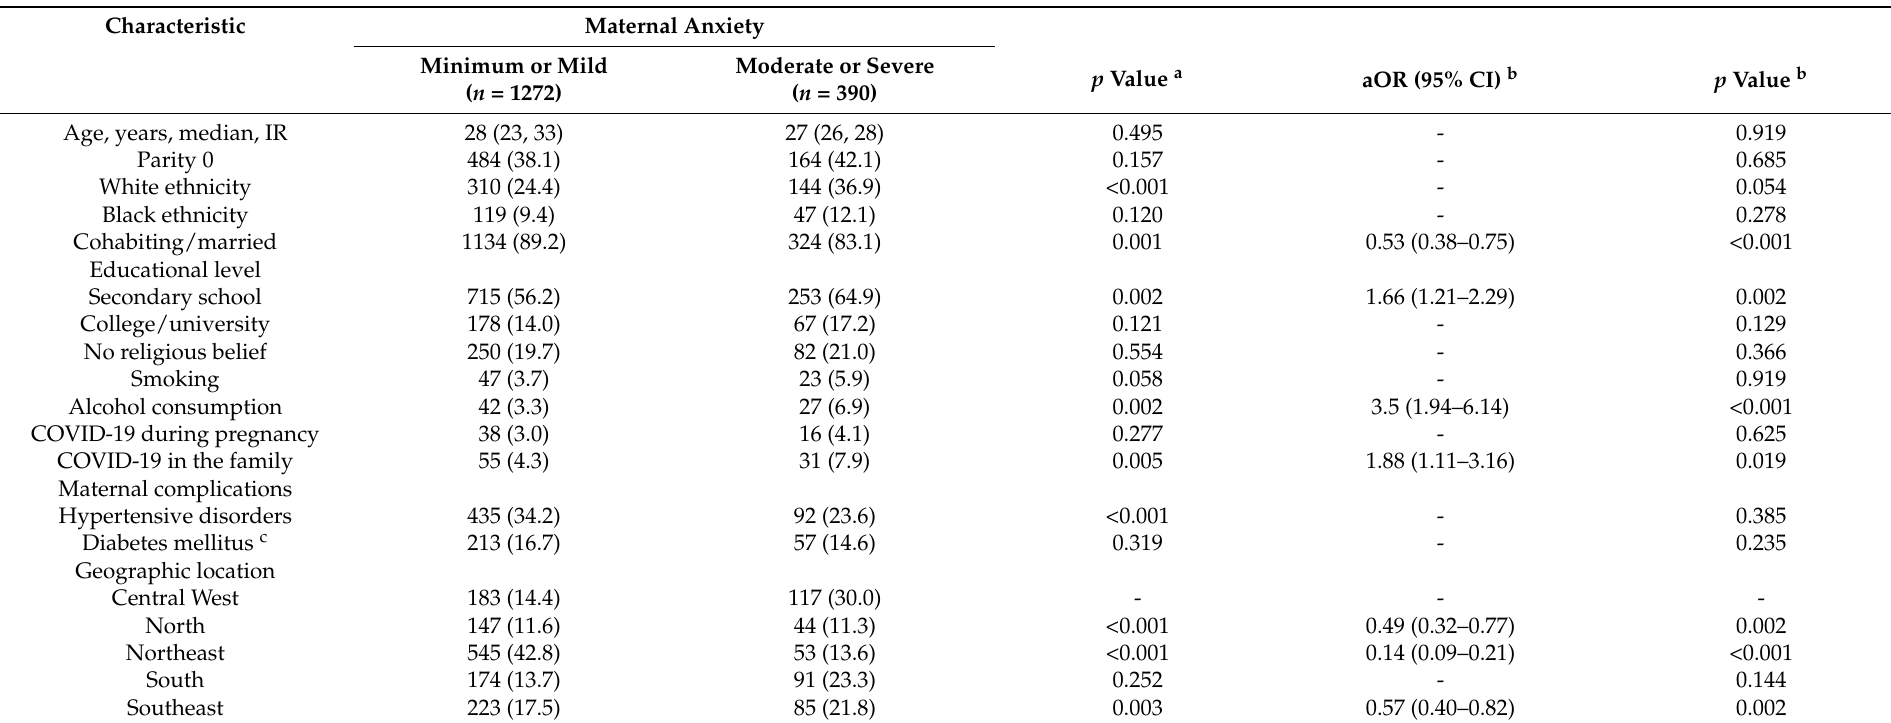
Table 3. Characteristics of women at birth, complications during pregnancy, and geographic region in Brazil according to moderate or severe maternal anxiety as assessed by the Beck Anxiety Inventory during the COVID-19 outbreak (June–August, 2020).